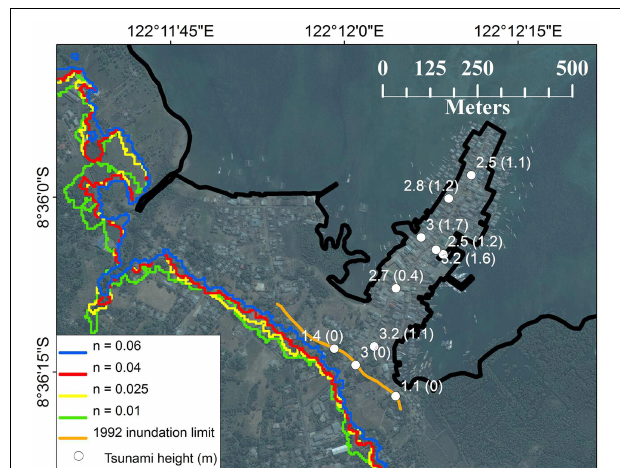
FIGURE 12 | Comparison between inundation limit (orange line) from georeferenced observational sketch from Tsuji et al. (1995) and ANUGA inundation models for Wuring Peninsula, Flores, for LiDAR DTM using onshore Manning’s n -values of 0.01, 0.025, 0.04, and 0.06. Mesh resolution is 7.62m. White numbers give tsunami heights from the field survey with tsunami flow depths in